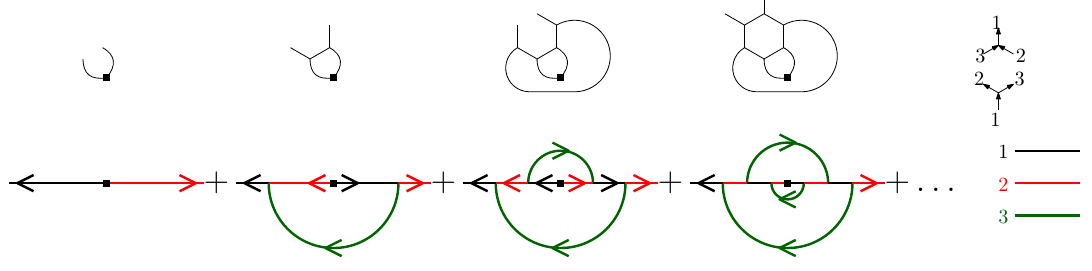
Figure 11 . Diagramatic expansion of (cid:6) 12 . The conventions are identical to those of (cid:12)gure